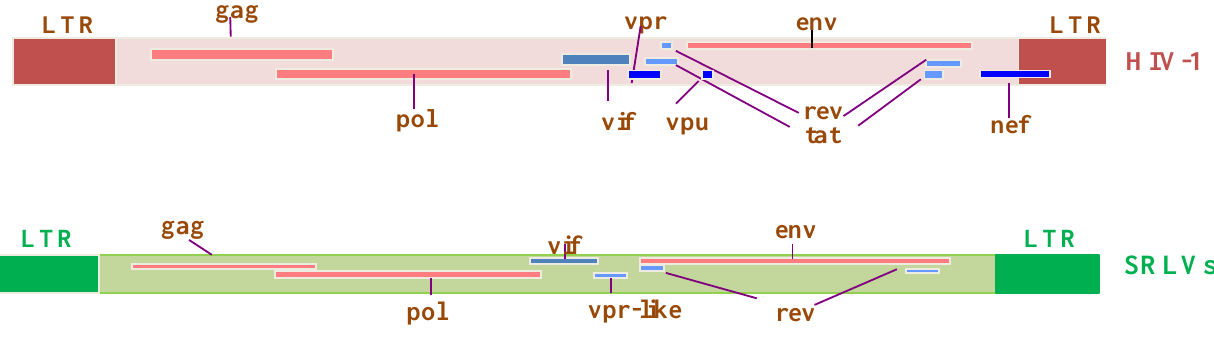
Figure 2. Genomic organization of HIV-1 and SRLV proviruses. Both genomes have the structural and enzyme gag , pol , and env genes (solid red bars), with LTRs at the 5’ and 3’ends (solid brown and green rectangles in HIV-1 and SRLVs, respectively) common to all retroviruses. The six additional open reading frames ( vif , vpr , vpu , tat , rev , and nef ) that encode regulatory and accessory proteins are indicated (solid blue bars), while the SRLV genomes have only three additional open reading frames ( vif , vpr-like , and rev )